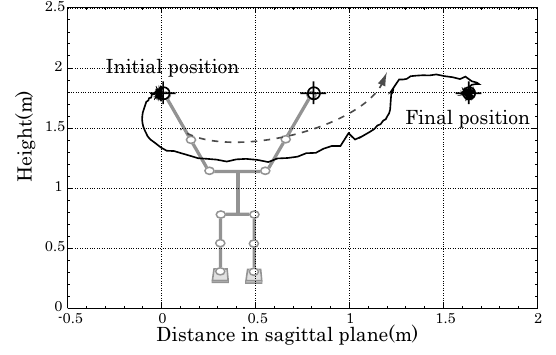
Figure 17 Trajectory of free hand during over-hand brachiation.